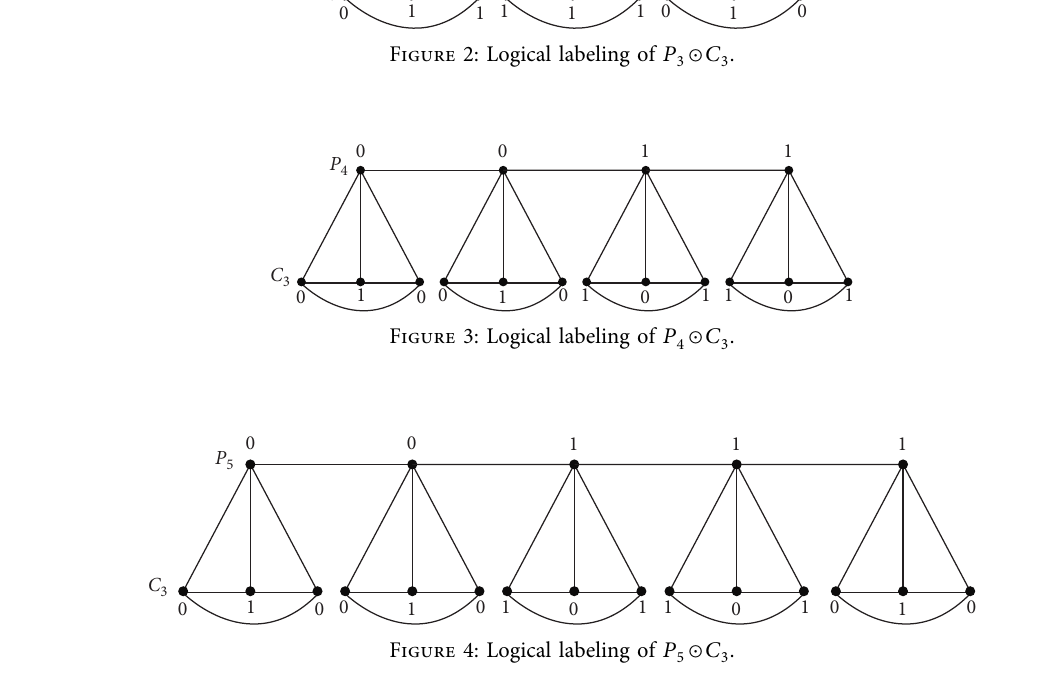
Figure 4: Logical labeling of P